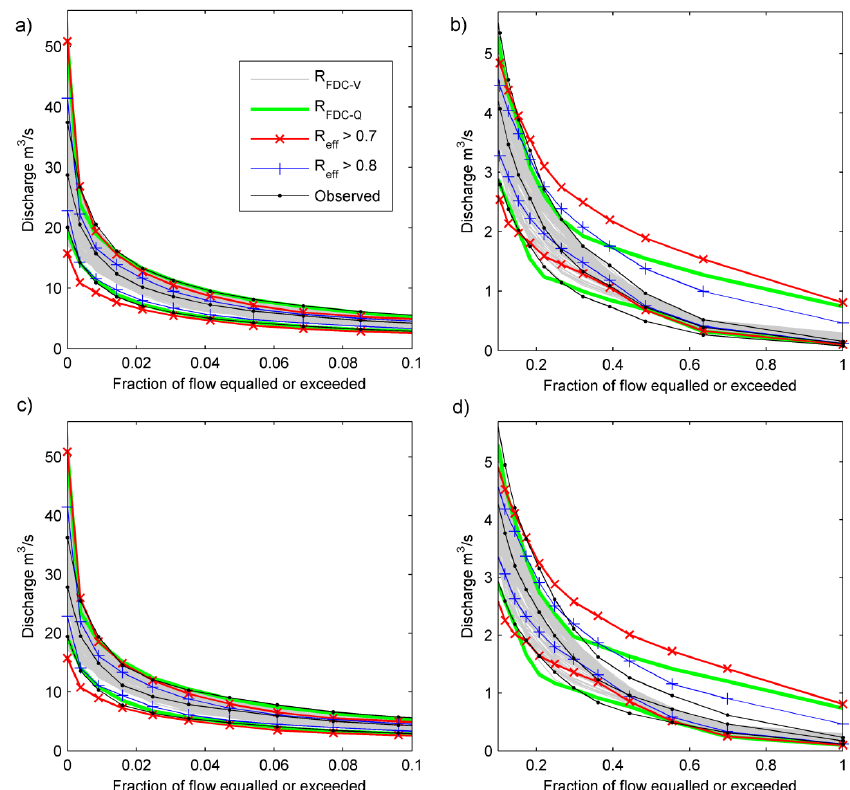
Fig. 10. (a) and (b) FDCs for behavioural parameter-value sets for Dynamic TOPMODEL in the Brue catchment for calibration in 1995–1996 using R FDC − V (all FDCs plotted as grey/shaded lines), R eff , and R FDC − Q (maximum and minimum FDC values plotted as lines) and observed crisp, upper and lower discharge; (c) and (d) FDCs for prediction in 1997–1998 using the behavioural parameter-value sets from 1995–1996. The FDCs are split in two plots (left – high flows and right – low flows) at 10% exceedance. All FDCs are plotted for the volume interval